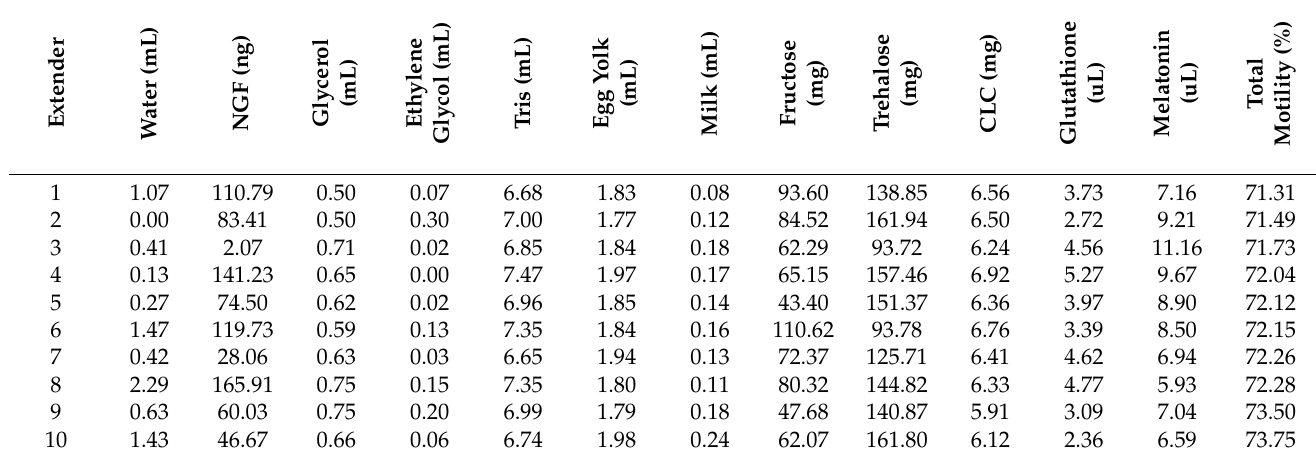
Table 5. The components and concentrations of the ten top extenders for total motility determined by the Monte Carlo